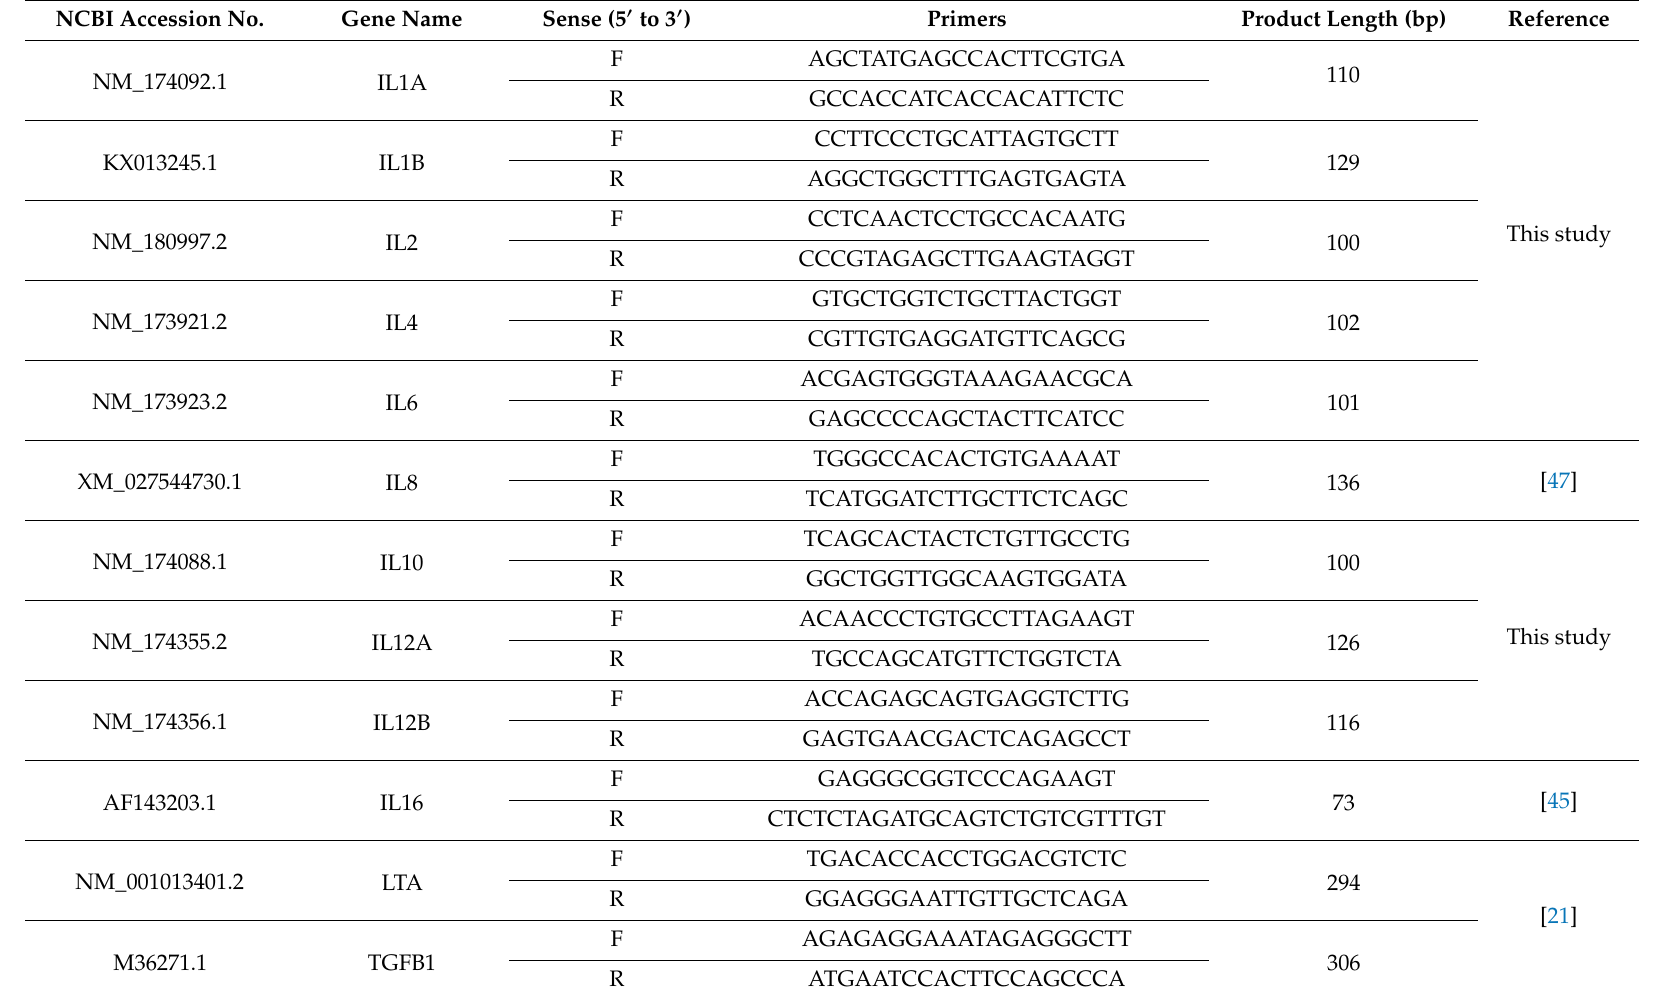
Table 1. Details regarding the qPCR primers used for the quantification of cytokine production in this study. NCBI Accession